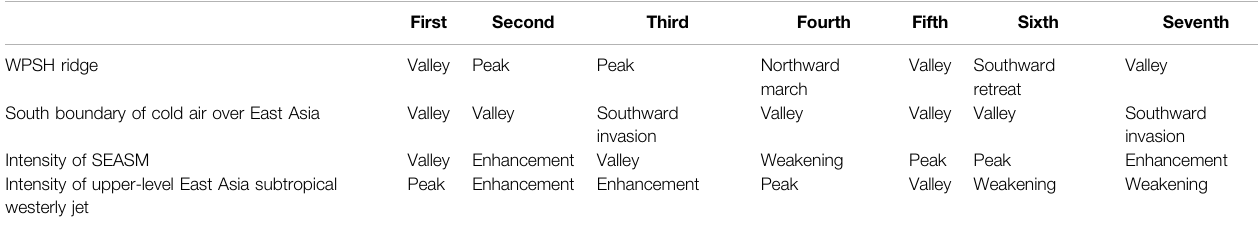
TABLE 1 | Behaviors of some ESAMS associated with fi rst to seventh round of precipitation processes during 2020